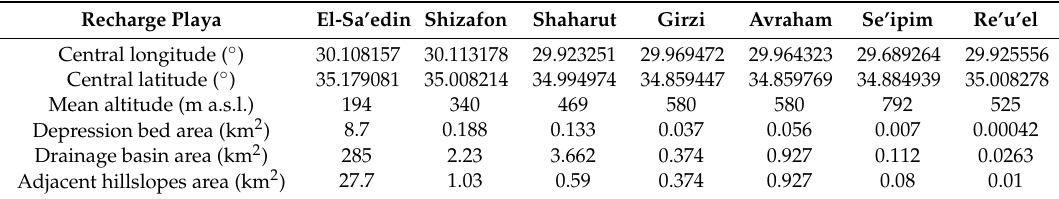
Table 1. Physical characteristics of the studied recharge